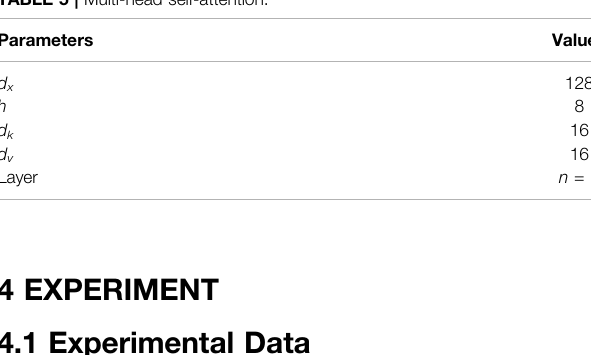
TABLE 2 | Character vector.